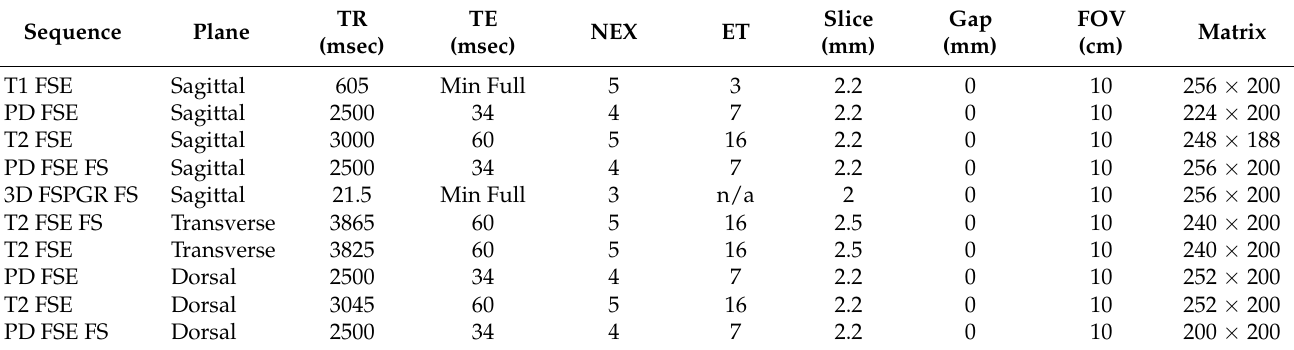
Table 2. The MRI scanning parameters of the canine stifle